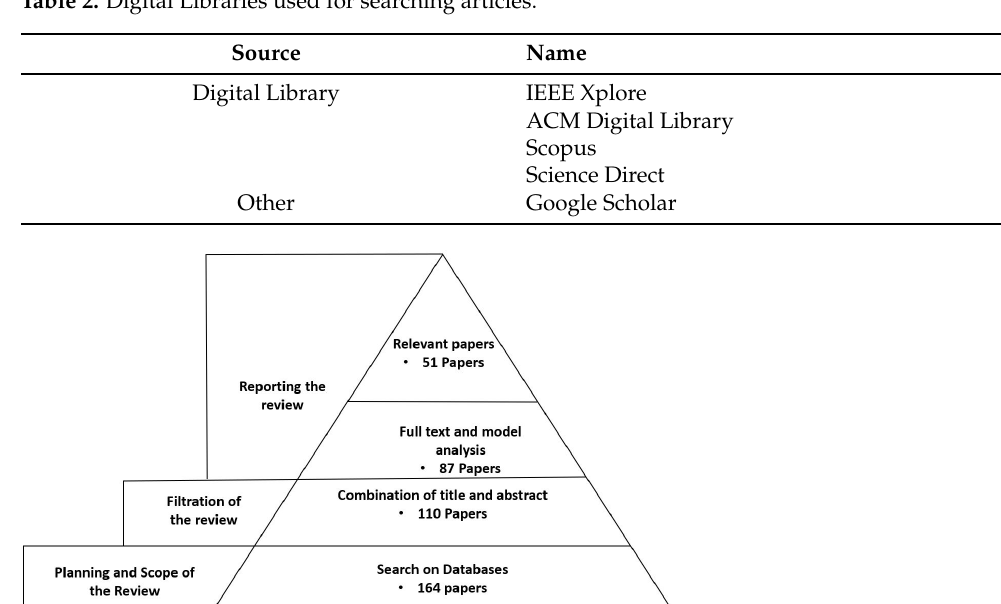
Table 2. Digital Libraries used for searching articles.